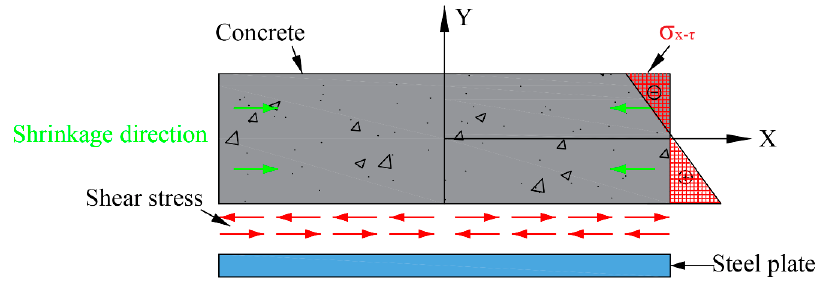
Figure 9. Analytical model of concrete restrained by a steel plate.